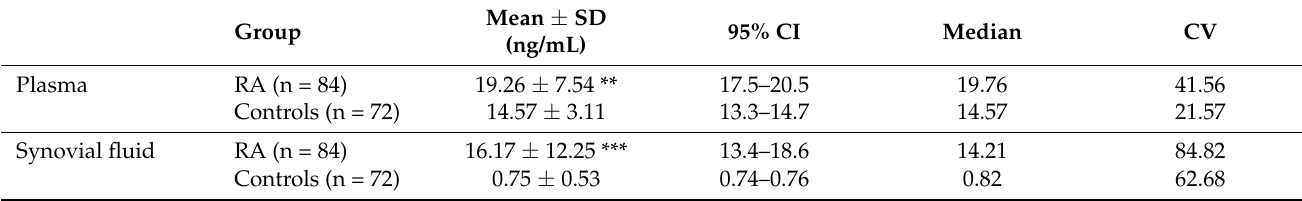
RA—rheumatoid arthritis; SD—standard deviation; n—number of subjects; CV—coefficient of variation; 95% CI—confidence interval for mean; ** p < 0.01; *** p <